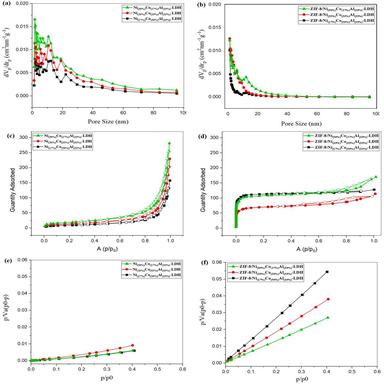
BJH plot of (a) NiCoAl-LDHs, and (b) ZIF-8/NiCoAl-LDHs. N2-adsorption-desorption isotherms of (c) NiCoAl-LDHs, and (d) ZIF-8/NiCoAl-LDHs. T-plot of (e) NiCoAl-LDHs, and (f) ZIF-8/NiCoAl-LDHs.